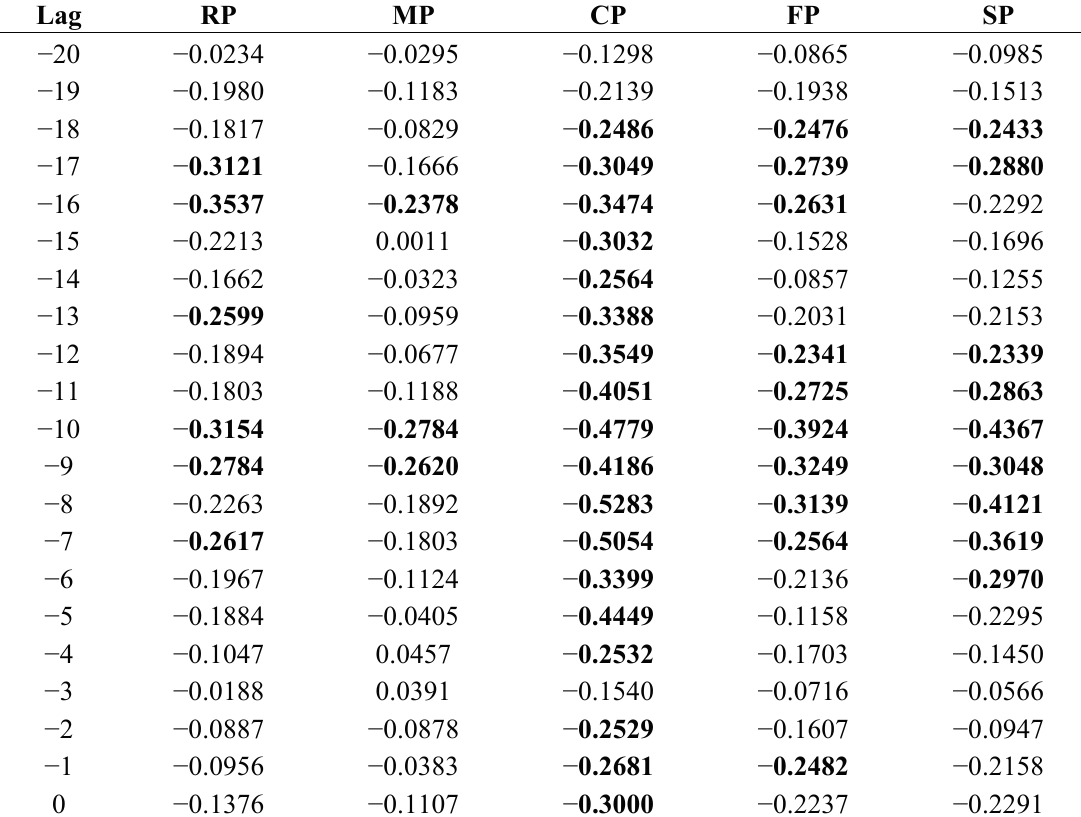
Table 4. Correlation coefficients between the Atlantic Multidecadal Oscillation (AMO) and annual rainfall time series for the Pampa